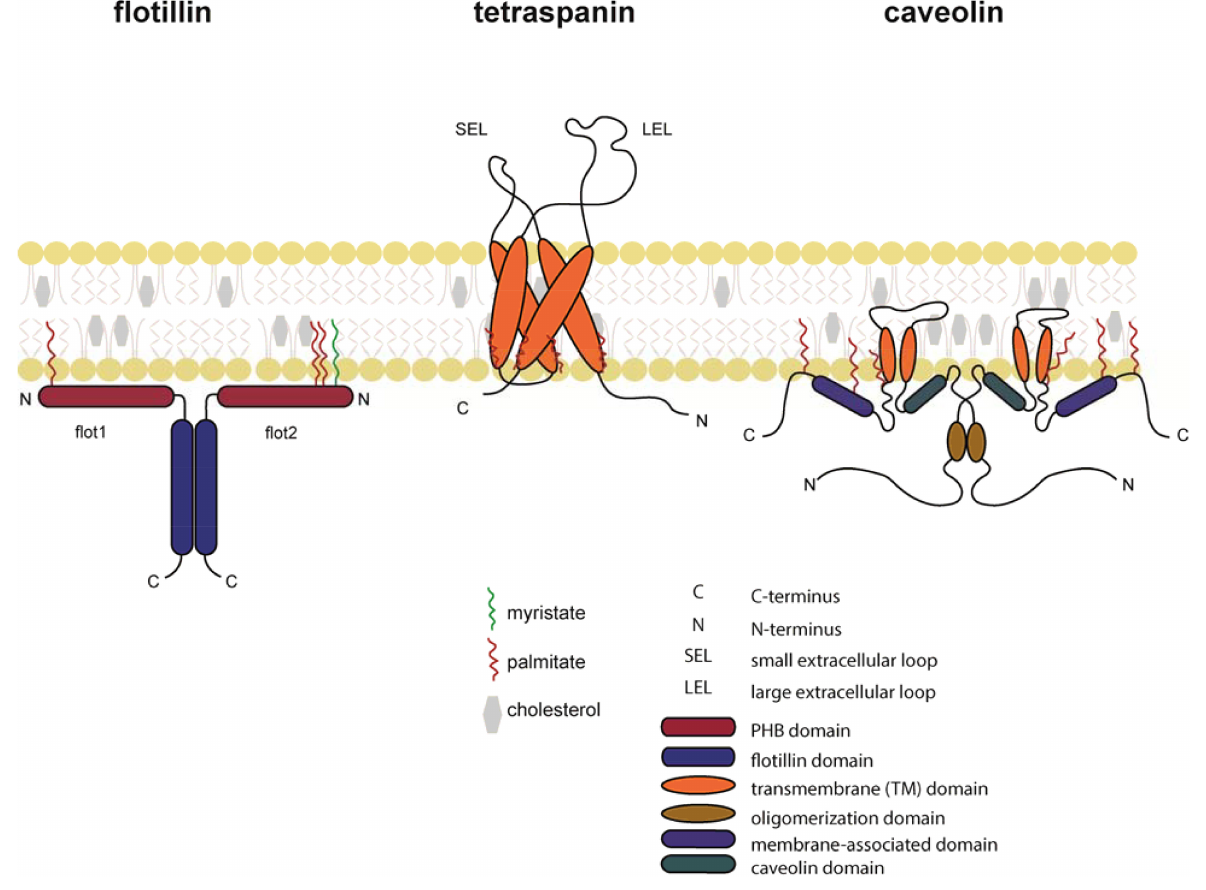
FIGURE 2 | Schematic representation of flotillin, tetraspanin, and caveolin in the lipid bilayer. Flotillins are associated at the cytosolic leaflet of the plasma membrane through its N-terminal PHB domain. Membrane association is further assured through myristoylation (green) and palmitoylation (red). Flotillins form hetero-mers through specialized intracellular flotillin domains. Tetraspanins are composed of four transmembrane α -helices and two extracellular domains: the SEL (small extracellular loop) and the LEL (large extracellular loop). Tetraspanins are palmitoylated at a conserved CXXC motif in their transmembrane domains. Caveolins form hairpin loops that are inserted into the plasma membrane. Both N- and C-termini face the cytoplasmic side of the